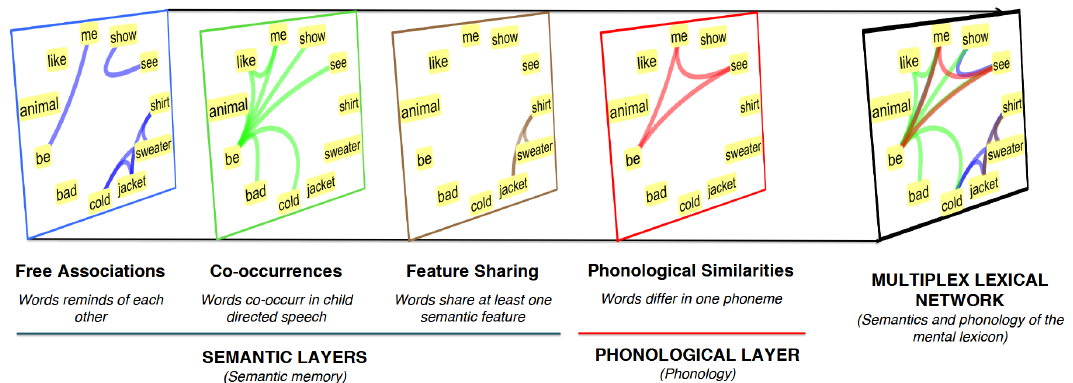
Figure 1. Visualisation of a subgraph of the multiplex lexical network used for predicting early word learning. Words are represented as nodes and are replicated across all network layers. A network layer represents a given aspect of the mental lexicon, namely free associations, semantic feature sharing, co-occurrences and phonological similarities. The different layers are equivalent to projecting all links onto a single network while keeping links of different layer/colours as distinct, as highlighted in the right-most